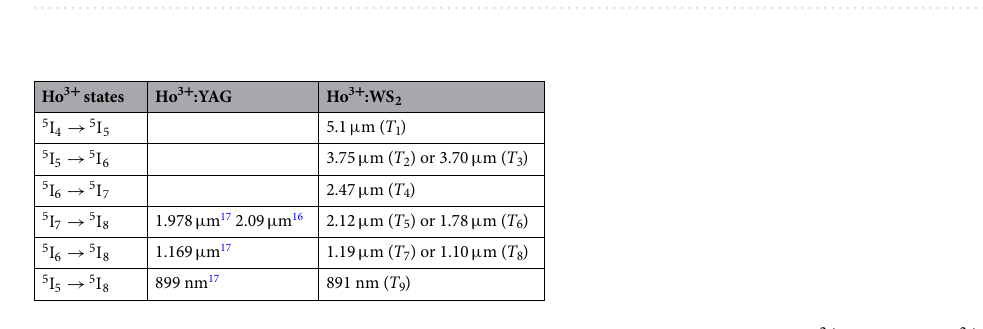
Table 6. Resonance wavelength of optical transitions (absorption and emission) for Ho 3 + :YAG and Ho 3 + :WS 2 . The absorption transitions in Ho 3 + :WS 2 are labeled according the optical spectrum shown in Fig. 7.